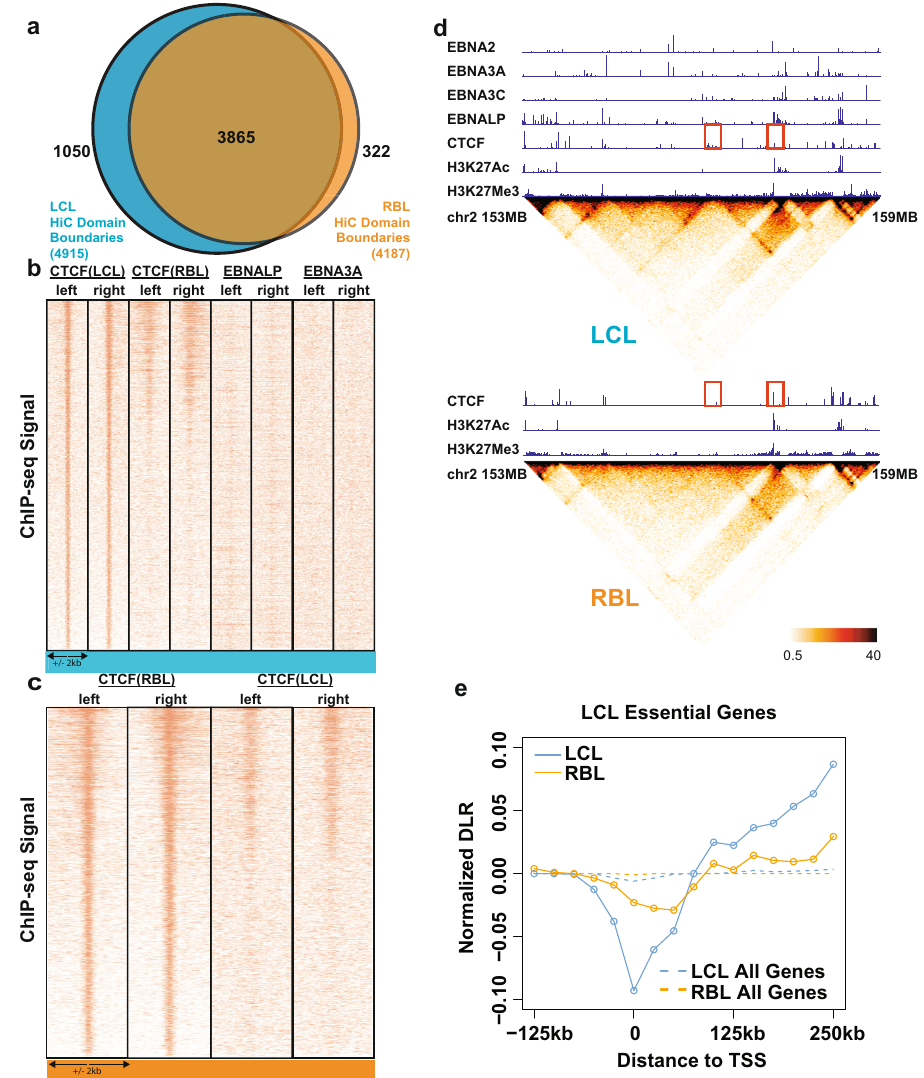
Fig. 2 | Global changesincontactdomainboundariesin RBLsand LCLs. a Venn diagram representing the contact domain boundaries from Hi-C in RBLs and LCLs. b ChIP-seq signals for CTCF in LCLs and RBLs, EBNALP and EBNA3A were plotted along the edges of LCL unique boundaries (centered on CTCF, +/ − 2kb). Left and rightindicatetherelativeedgepositionsofthecontactdomainboundaries. c .ChIP- seq signals for CTCF in RBLs and LCLs plotted along the edges of RBL unique boundaries(centeredonCTCF,+/ − 2kb). d Representativecontactdomainchanges duetoEBVtransformationatchromosome2,153Mb – 159Mb.Top:ChIP-seqtracks